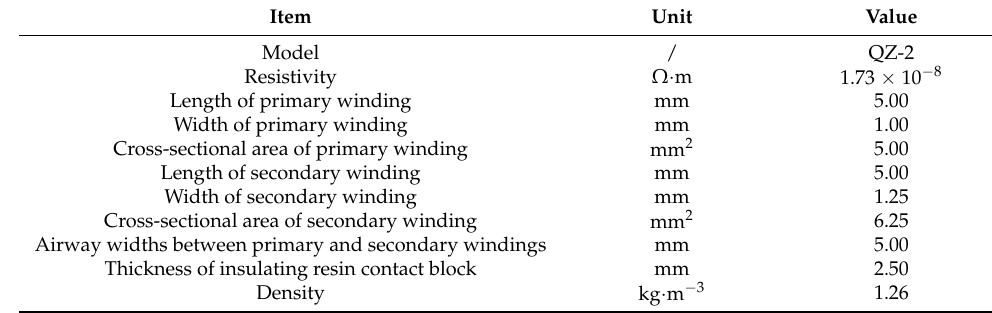
Table 2. Wire specific parameters.